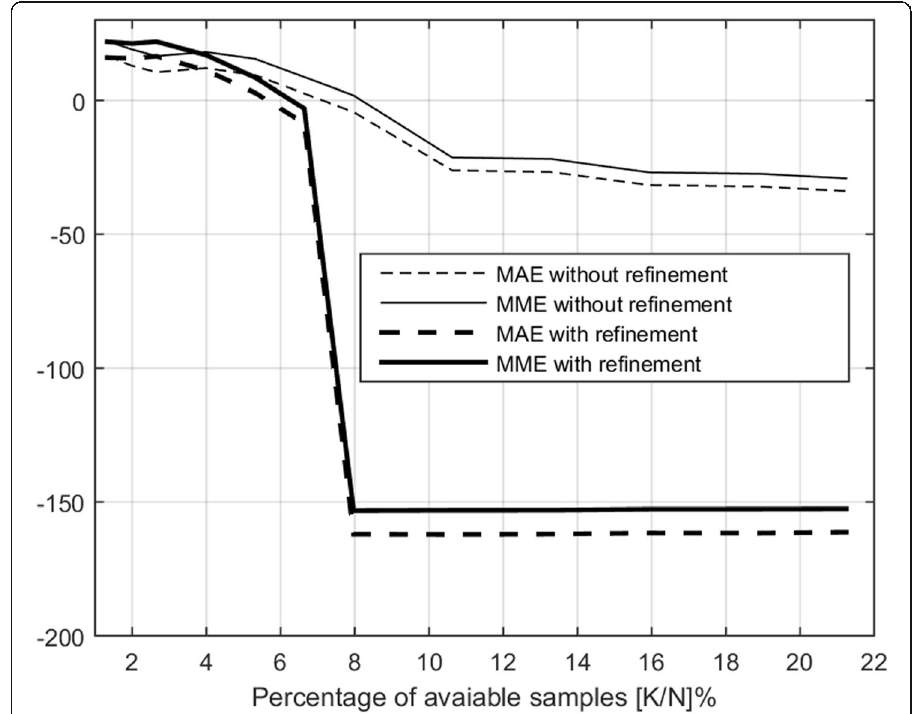
Fig. 4 Statistics (MAE — dashed lines, MME — solid lines; thin lines — without refinement; thick — with refinement) for the RANSAC application to the cubic phase